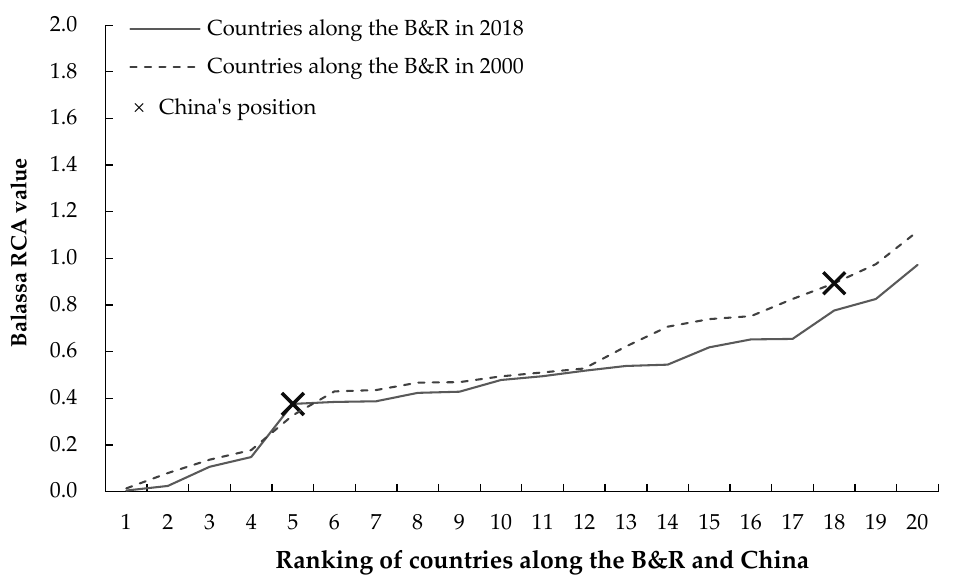
Figure 2. The Balassa RCA values of total agricultural trade in countries along the B&R and China in 2000 and 2018. The x -axis represents the ranking of countries along the B&R and China based on the Balassa RCA values in 2000 and 2018; and the y -axis represents the Balassa RCA value.